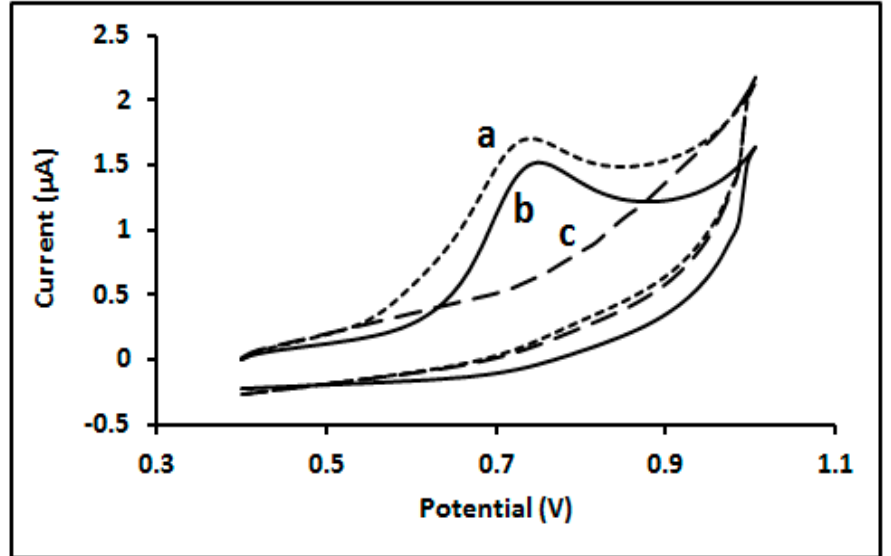
Figure 2. Cyclic voltammogram of ( a ) 50 μ M 4 ‐ MU; ( b ) 50 μ M CFN; ( c ) in absence of both analytes; at glassy carbon electrode in 0.1 M BR buffer (pH, 7) solution.